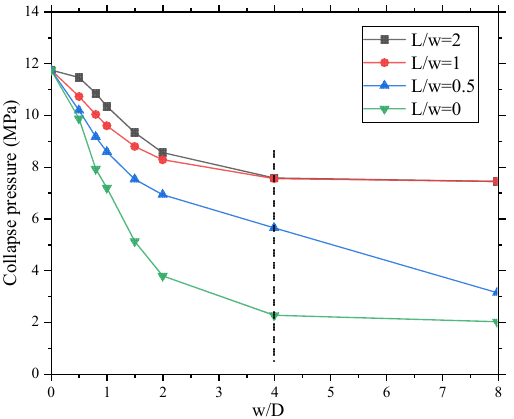
Figure 21. Repairing effect of CFRP on defects of different lengths.